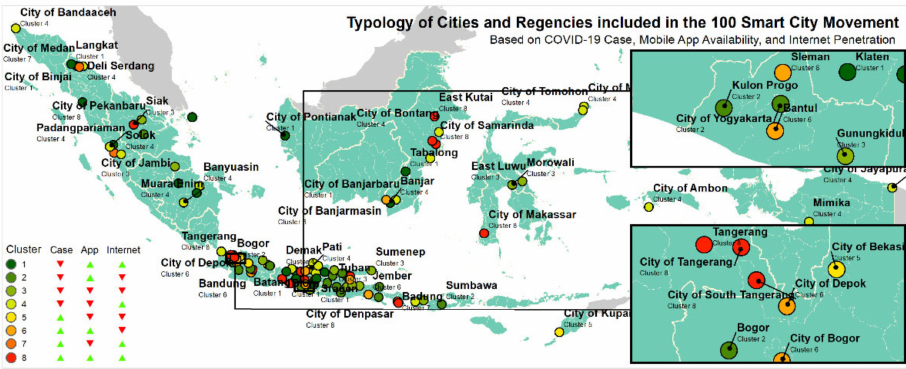
Figure 9. Distribution map of the typology of cities and regencies included in the 100 Smart City movement in Indonesia, based on confirmed COVID-19 cases, mobile app availability, and inter- net